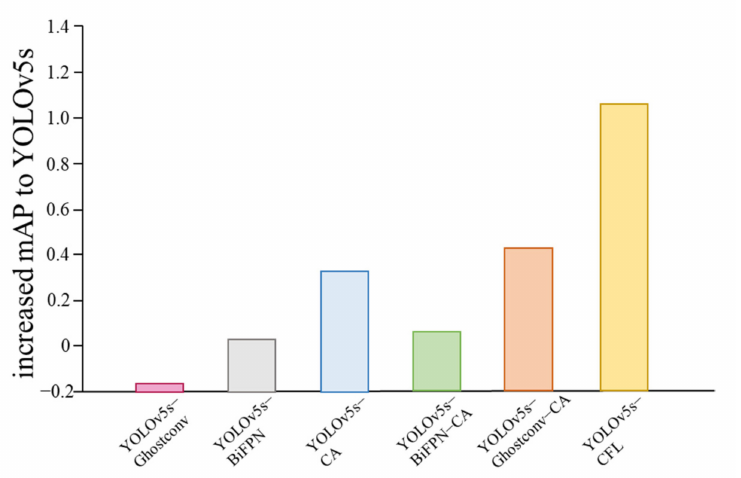
Figure 9. Increased mAP compared to the original YOLOv5s model by each combination using Xiaomila green pepper